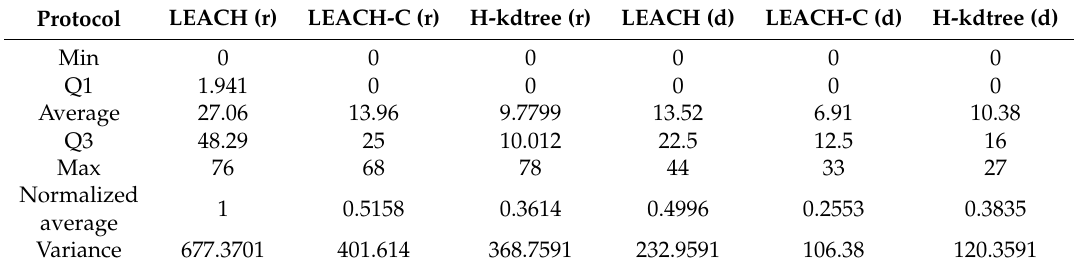
Table 5. Number of death nodes with 200 nodes. (r) random—(d)